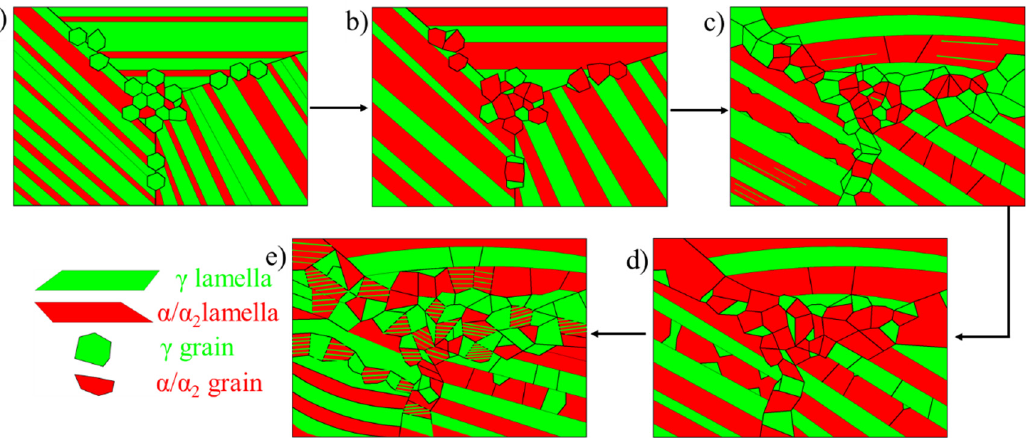
Figure 11. Microstructure evolution model of Ti-44Al-8Nb-(W, B, Y) alloy at 1250 °C during hot rolling. ( a ) Original microstructure, ( b ) microstructure after annealing by rolling for 2 h, ( c ) microstructure after the first rolling pass, ( d ) microstructure after annealing for 15 min between two rolling passes, and ( e ) microstructure after one more rolling pass.